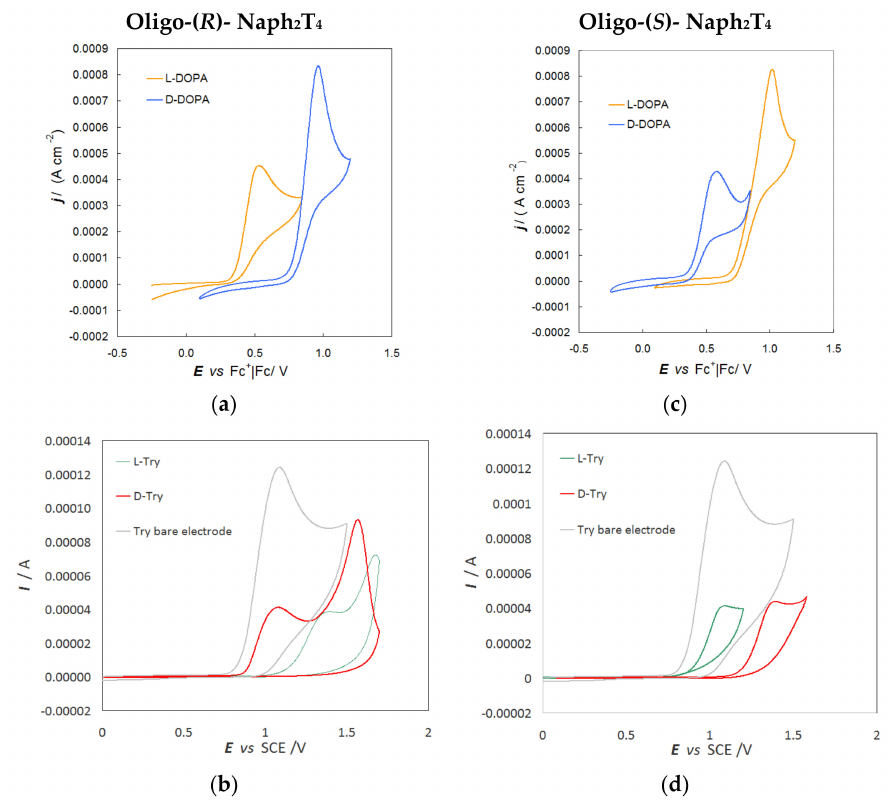
Figure 10. Enantiodiscrimination CV tests in aqueous solution with 0.05 M HCl as the supporting electrolyte, performed on a GC electrode modified with oligo-( R )-Naph 2 T 4 and oligo-( S )-Naph 2 T 4 enantiopure films ( a , b , c , d ) electrodeposited in dichloromethane, with the enantiomers of two chiral probes: ( l )- and ( d )-DOPA (( a , c ), yellow and blue lines respectively) and ( l )- and ( d )-tryptophan (Try) (( b , d ), green and red lines respectively; in the ( R )-film case, the second oxidation peaks of the chiral probes are also reported).